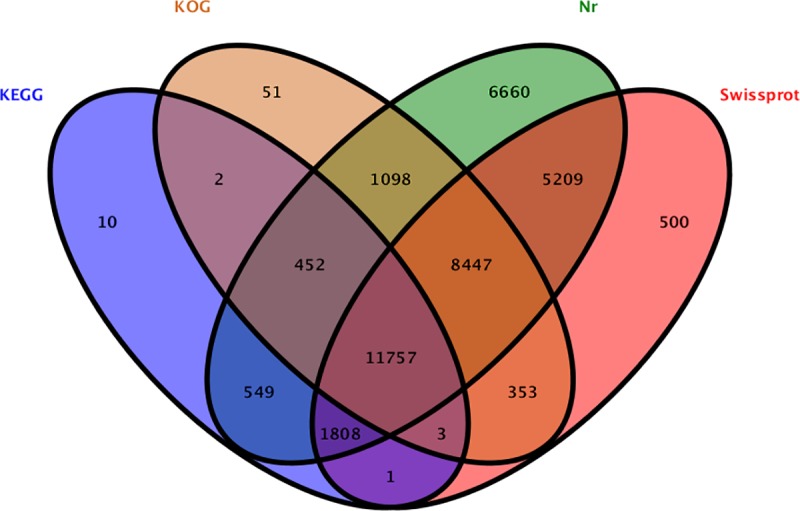
Venn diagram of annotation results.